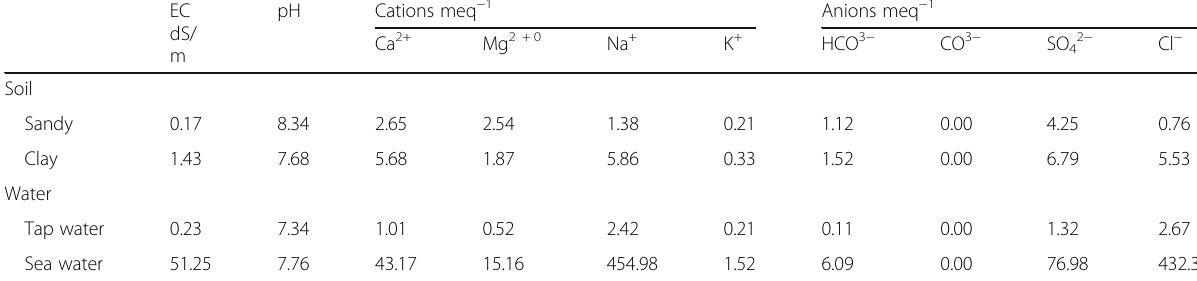
Table 1 EC, pH, and concentrations of cations and anions of irrigation water and soil used in pots EC pH Cations meq − 1 Anions meq − dS/ m